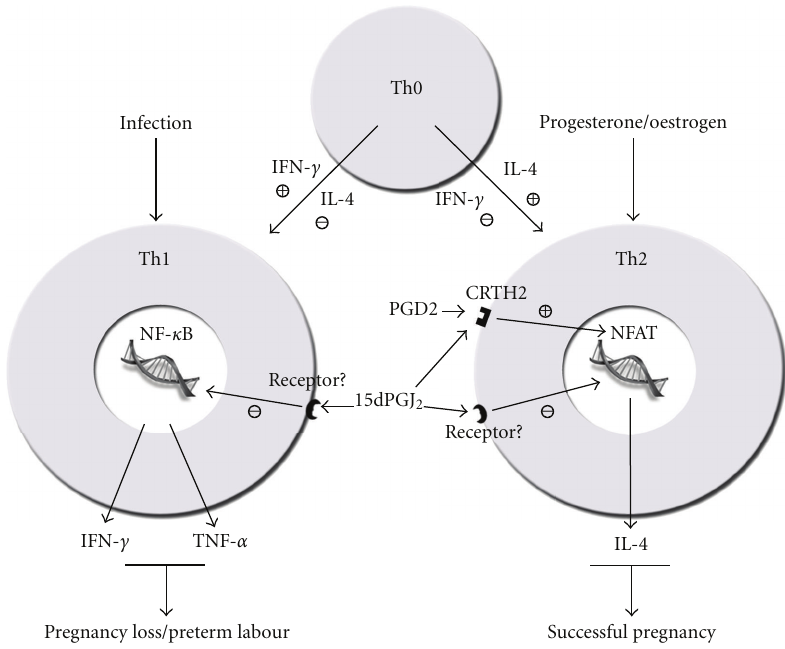
Figure 5: Schematic proposal of the Th1 and Th2 balance and the role of CRTH2 and NF- κ B. T-helper cell precursors are directed toward committed immunophenotype by the typical Th1 and Th2 interleukins, IFN- γ and IL-4, respectively. Infection or propregnancy hormones such as progesterone can further modulate the Th1/Th2 bias. Based upon our findings and those of others, we propose that 15dPGJ 2 maintains a Th2 bias principally through the suppression Th1 interleukins through the inhibition of NF- κ